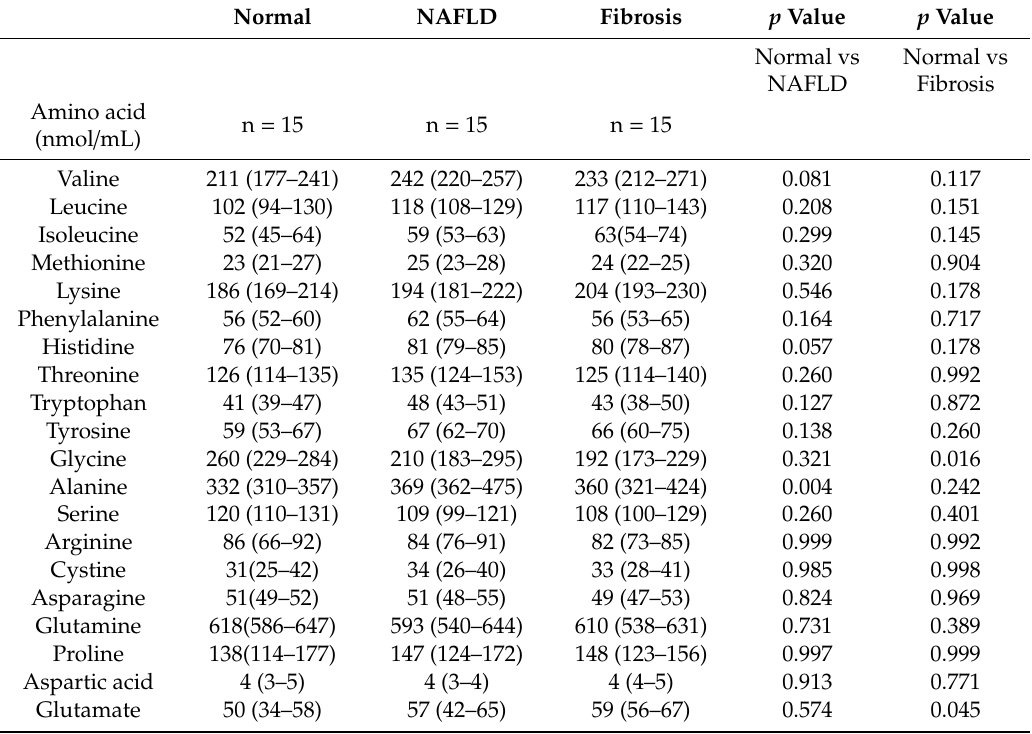
Table 5. Amino acid composition after matching for insulin resistance.